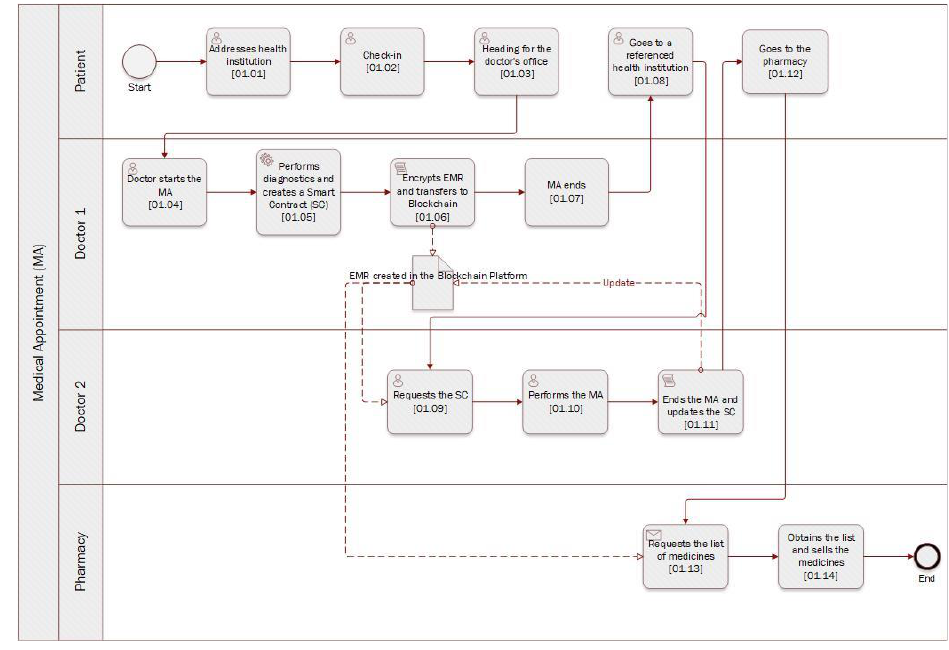
Figure 5. Information flow chart.